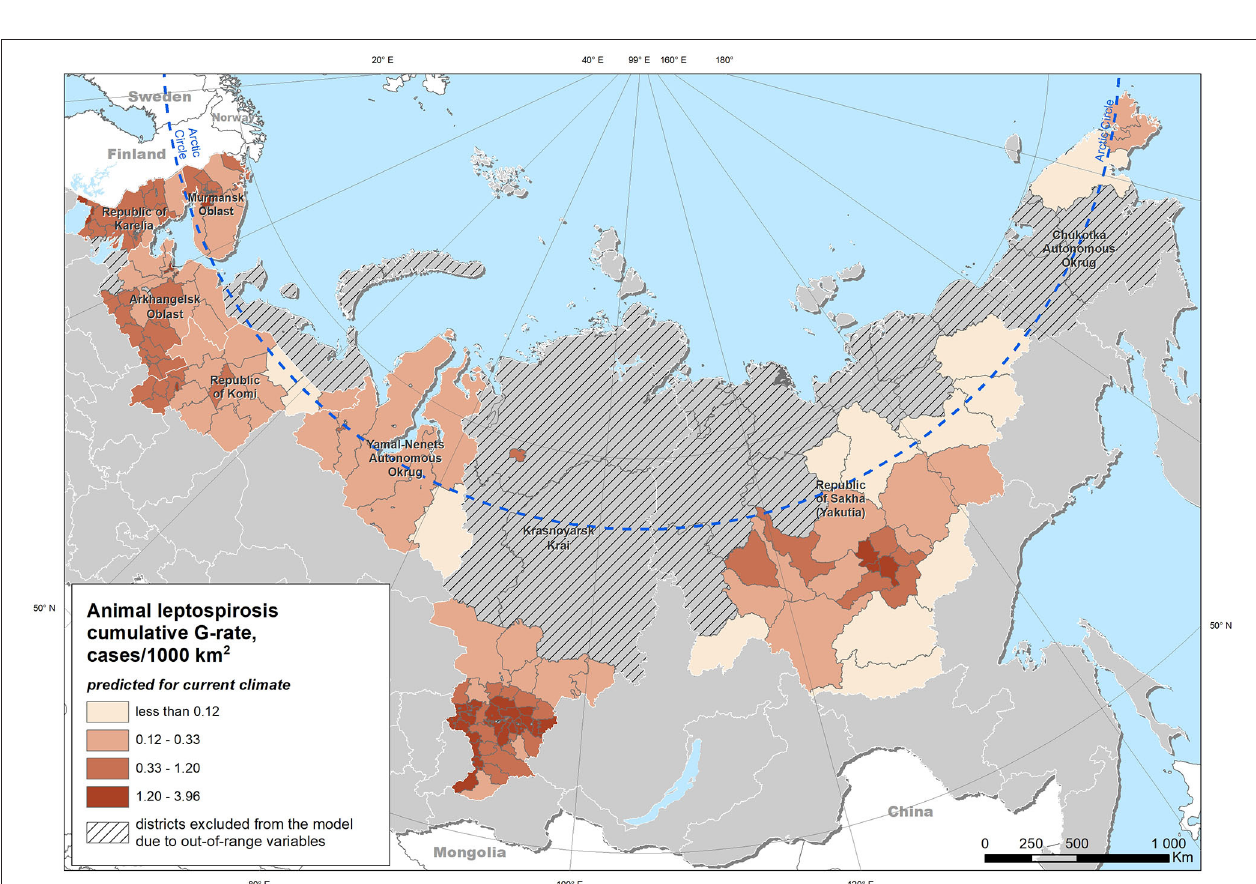
FIGURE 4 | Observed vs. Predicted animal leptospirosis log G-rate as per the model fit to the training districts.